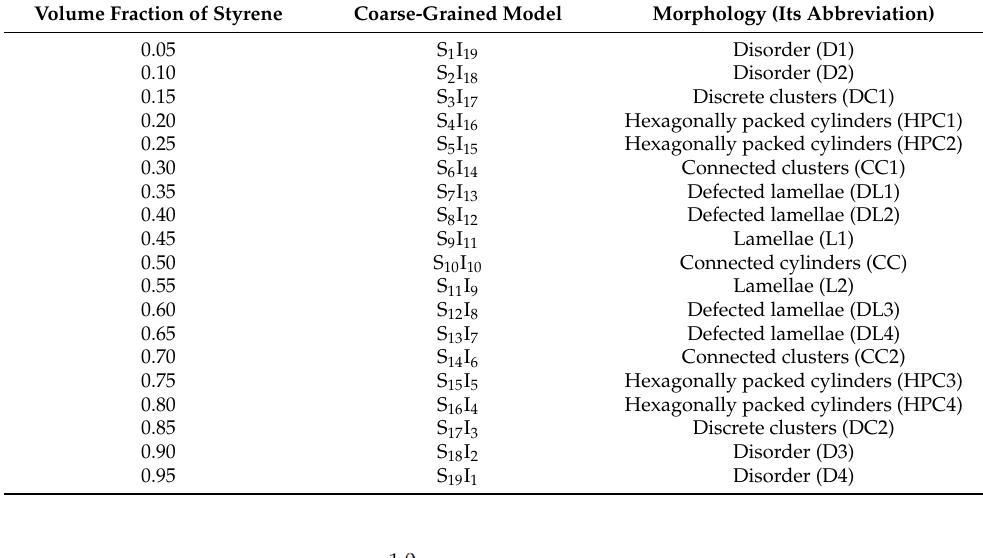
Table 2. Coarse-grained models and their morphological classification.